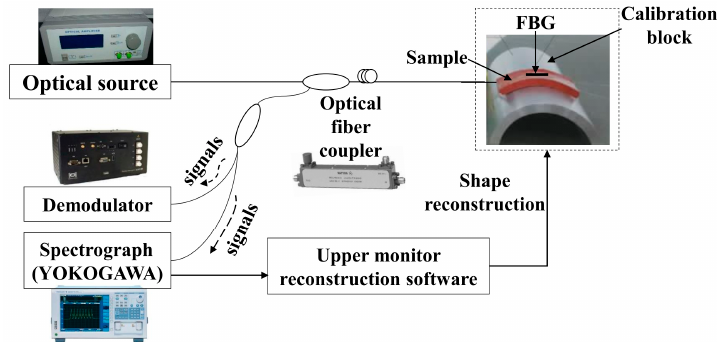
Figure 10. Experimental setup of the soft actuator with embedded FBGs.